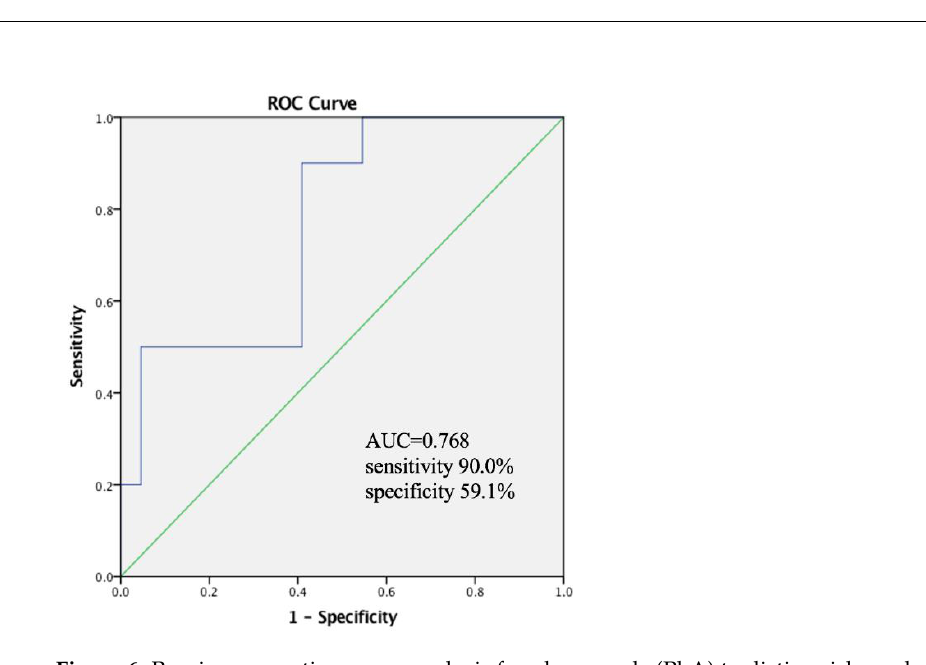
Figure 5. Receiver-operating curve analysis for phase angle (PhA) to distinguish moderate/severe malnutrition in man according to the GLIM criteria with optimal PhA level cut-off of 5.53°.